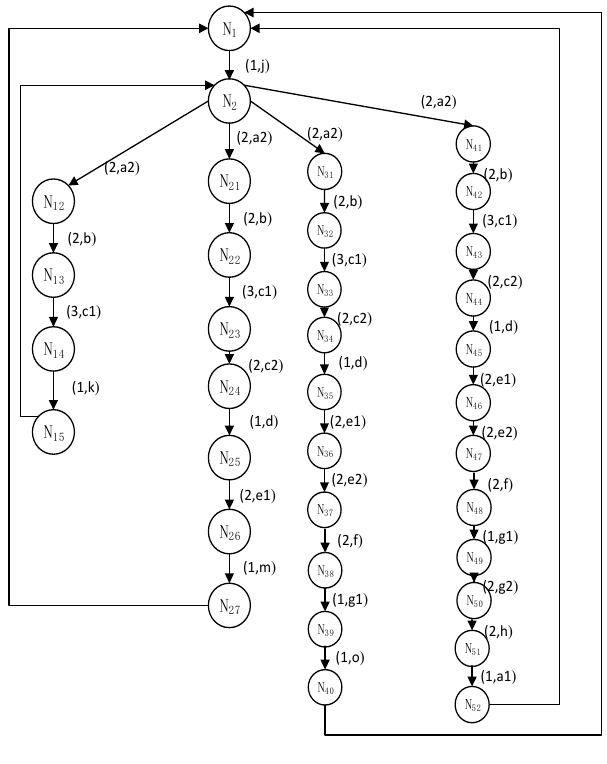
Figure 5. State space of Car1.